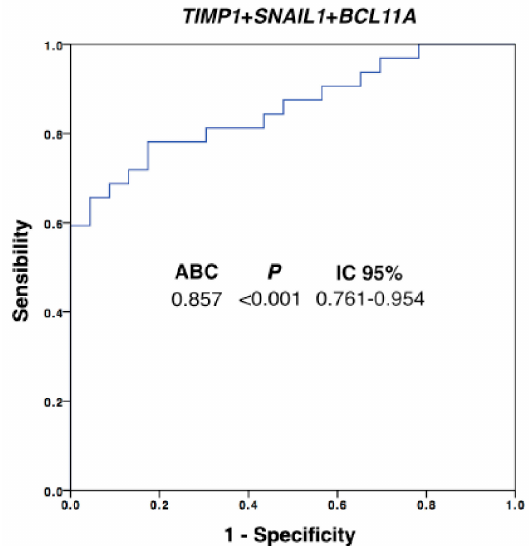
Figure 3. Logistic regression ROC model combining TIMP1 , SNAIL1 and BCL11A expression levels for patients’discrimination. Equation: Ln(odds) = 2.02 + (0.31 × TIMP1 expression ) + (0.05 × SNAIL expression ) + (0.55 × BCL11A expression ); AUROC, area under the ROC curve; CI, confidence interval. Healthy controls, n = 30; patients, n =